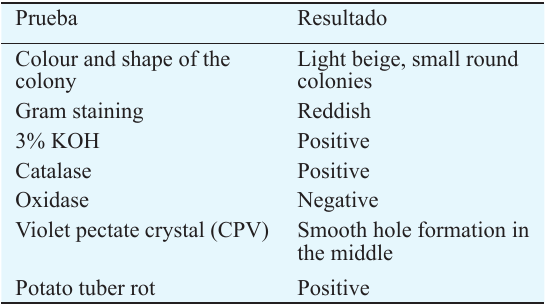
Table 1. Phenotypic test